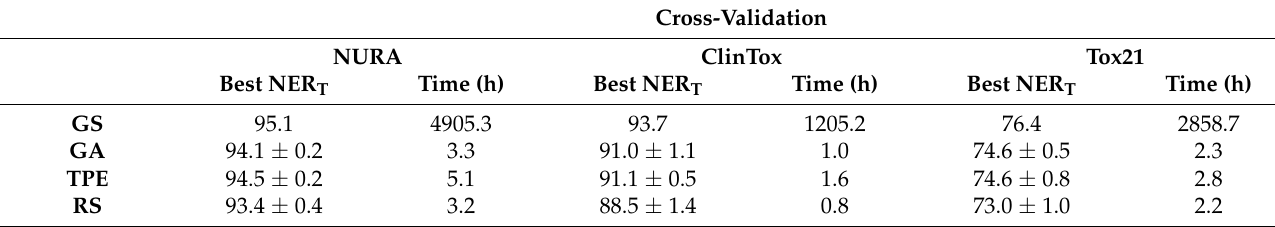
Table 1. Results in terms of overall non-error rate (NER T ) considering grid search (GS), genetic algorithms (GA), random search (RS), and tree-structured Parzen estimator (TPE) as optimization strategies in 3-fold cross validation. The computational time for 3-fold cross-validation is also reported in hours (h). Mean and confidence interval among 10 replicas are reported for GA, RS, and TPE results.